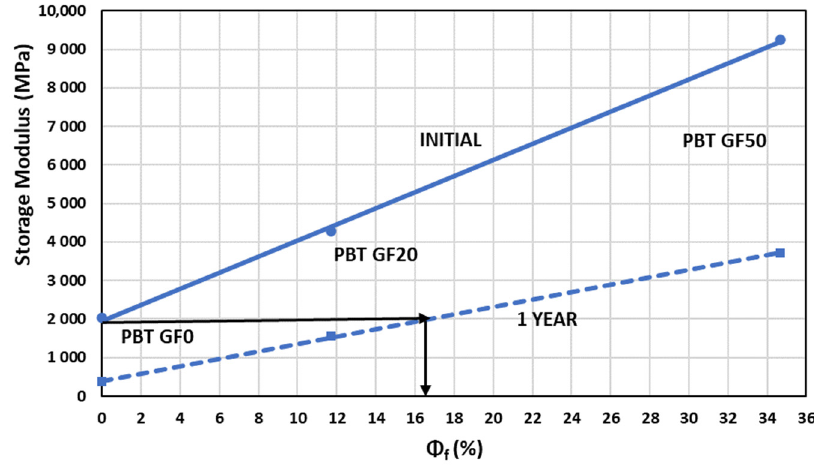
Figure 9. Variation in the storage modulus with the percentage of fiber volume depending on the exposure status.